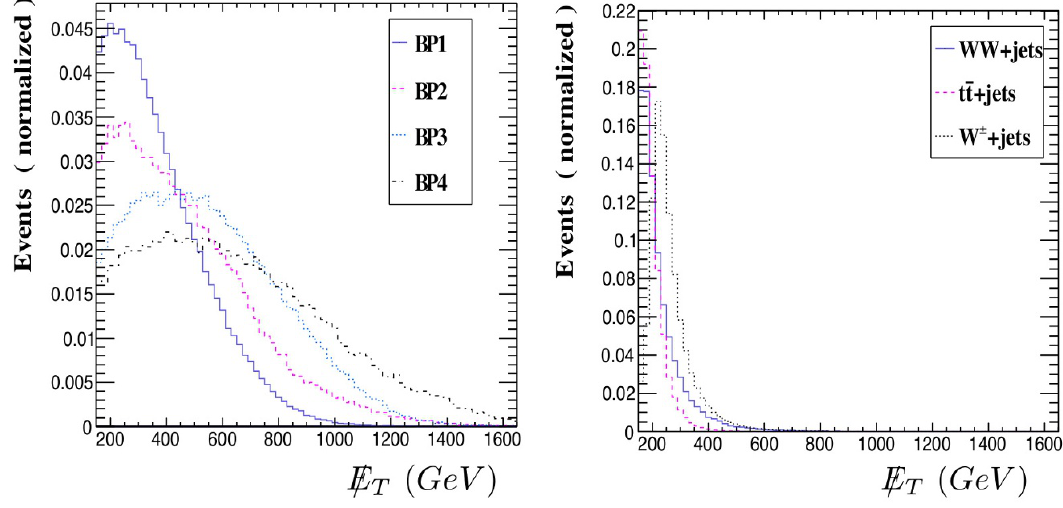
Figure 4 . Same as in (cid:12)gure 3 but for the missing transverse energy =E